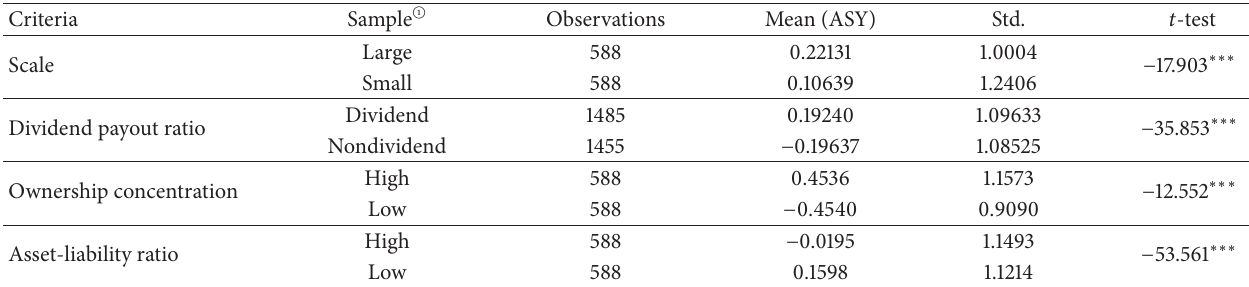
Table 5: ASY based on different